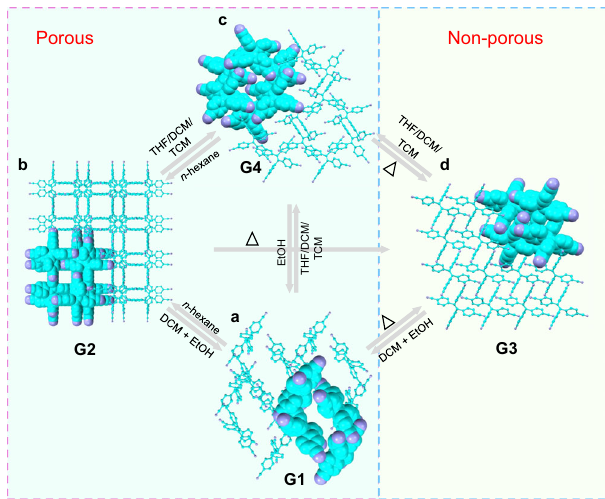
Fig. 6 Multimode reversible transformations of 4CN. a Packing diagram of G1 : 4CN(ET2) and 4CN(MT). b Packing diagram of G2 : 4CN(ET1), 4CN(Hex), 4CN(Hep), 4CN(Oct), 4CN(Dec), and 4CN(Dod). c Packing diagram of G4 : 4CN(THF), 4CN(DCM), and 4CN(TCM). d Packing diagram of G3 : 4CN(Non1) and 4CN(Non2). ‘ Δ ’ indicates